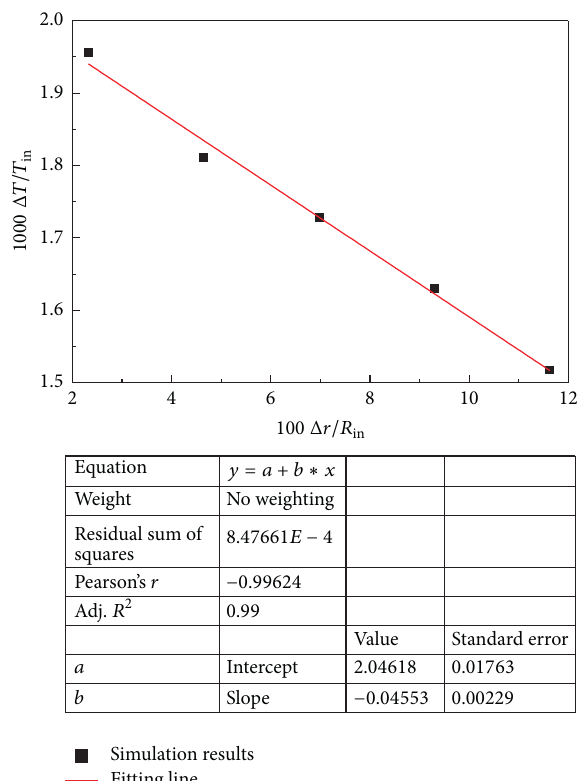
Figure 8: The dimensionless minimum temperature drop ( Δ𝑇/𝑇 versus dimensionless erosion reduced thickness ( Δ𝑟/𝑅